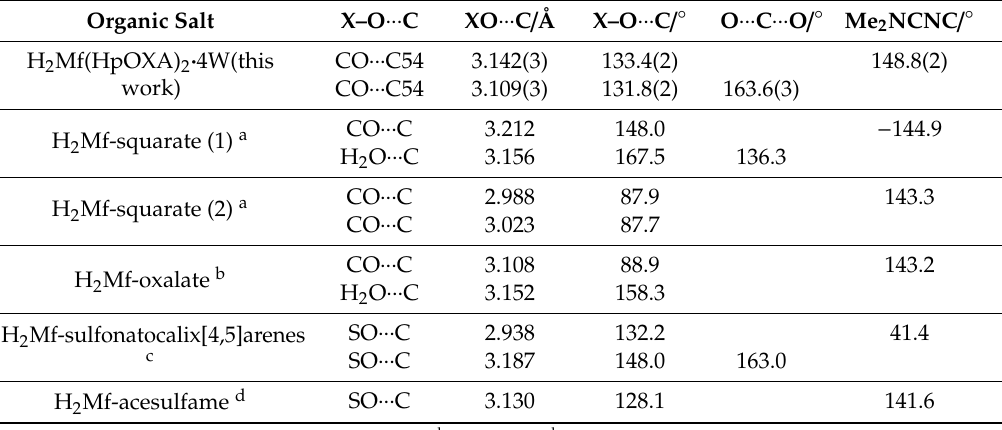
Table 6. Geometric parameters of regular O( δ − ) ··· C( δ + ) and bifacial O( δ − ) ··· C( δ + ) ··· O( δ − ) n → π * interactions reported in H 2 MfA organic salts (A =